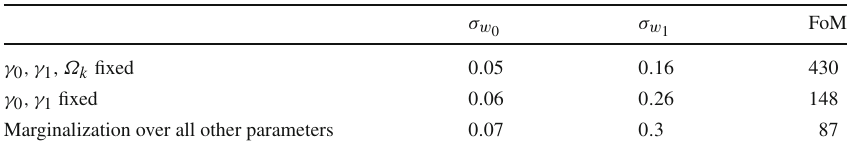
√ = ( 1 + z ) . The blue dashed ellipses are obtained σ w σ w FoM 0 1